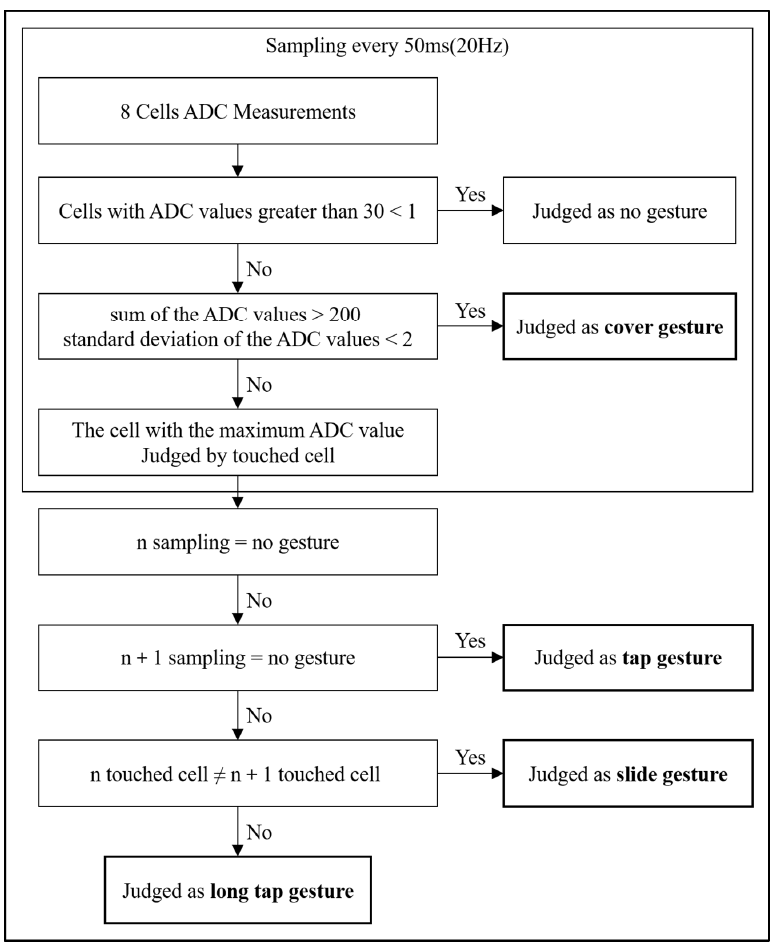
Figure 9. Examples of the operation of the camera, music, document, voice command, and mode conversion of the developed smart bag prototype (Supporting Video S2). conversion of the developed smart bag prototype (Supporting Video